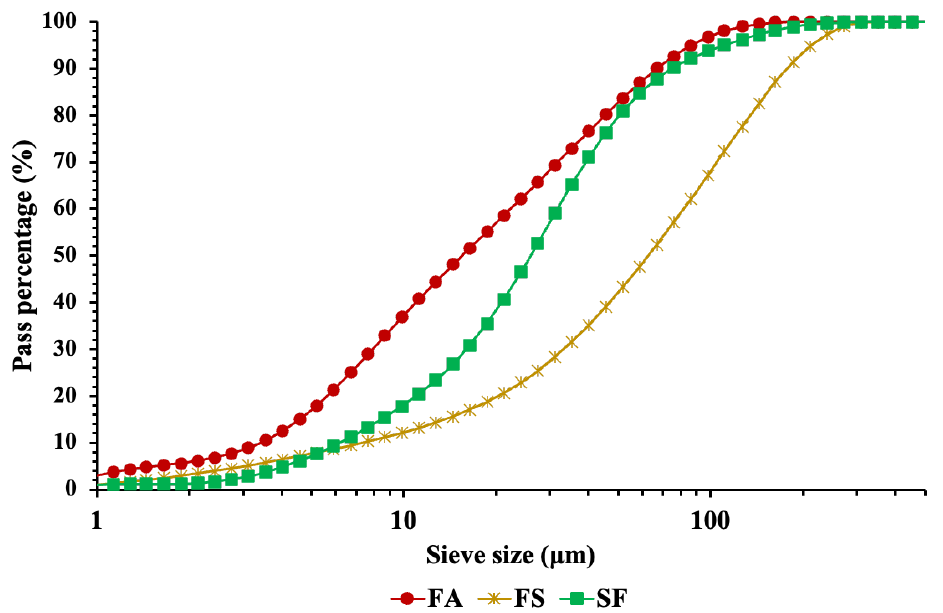
Figure 3. Particle size distribution of FA, FS, and SF.